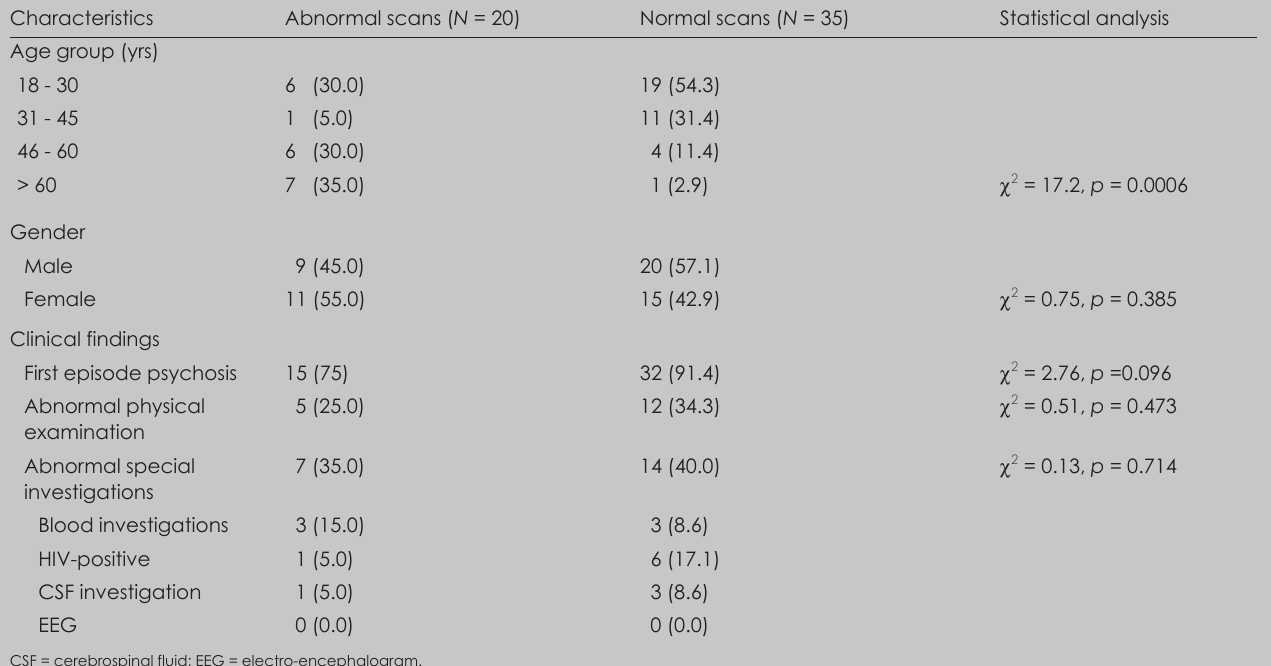
Table II. Demographic and clinical characteristics of the study sample ( N (%))